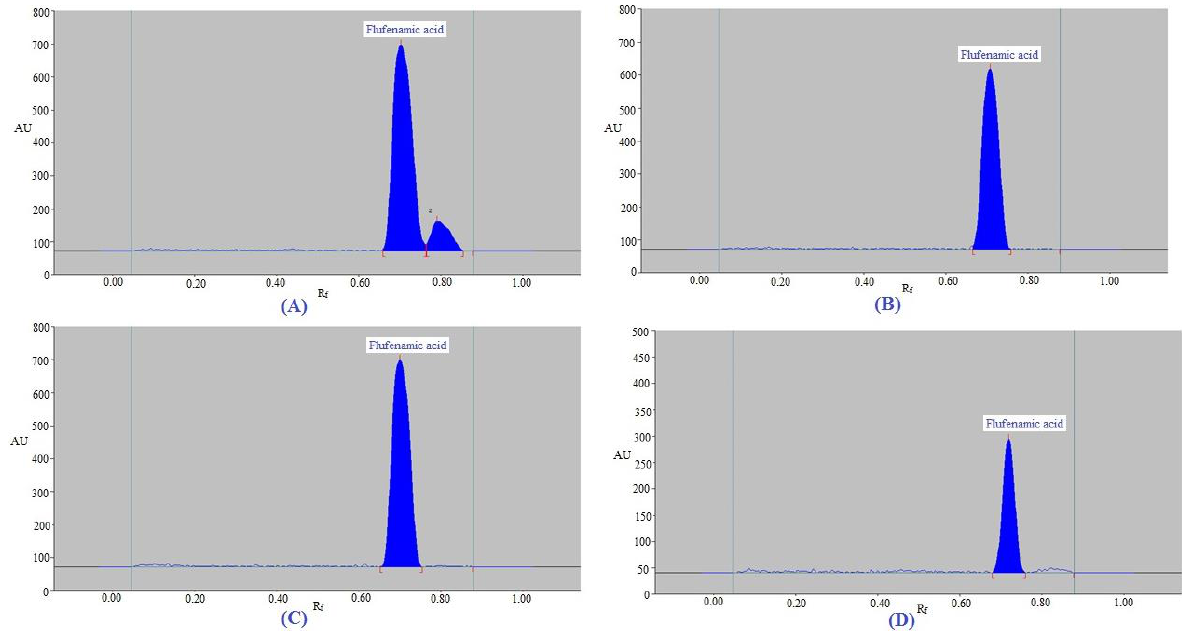
Figure 5. Representative densitometry chromatograms of FFA derived under ( A ) acid-induced deg- radation, ( B ) base-induced degradation, ( C ) oxidative degradation, and ( D ) thermal degradation of FFA.